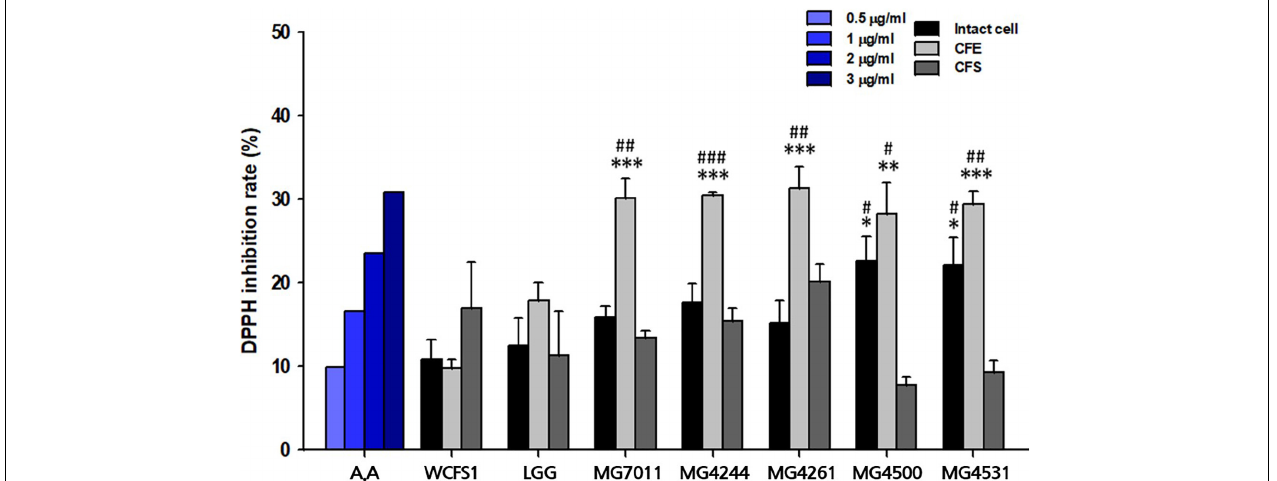
FIGURE 3 | Antioxidative activity of Limosilactobacillus fermentum strains. A represents ascorbic acid. Limosilactobacillus plantarum WCFS1 (WCFS1) and Limosilactobacillus rhamnosus GG (LGG) were used as positive controls. Data represent the mean ± SD ( n = 3). ∗ p < 0.05, ∗∗ p < 0.01, ∗∗∗ p < 0.001 compared with control strain WCFS1 and # p < 0.05, ## p < 0.01, ### p < 0.001 compared with control strain LGG.